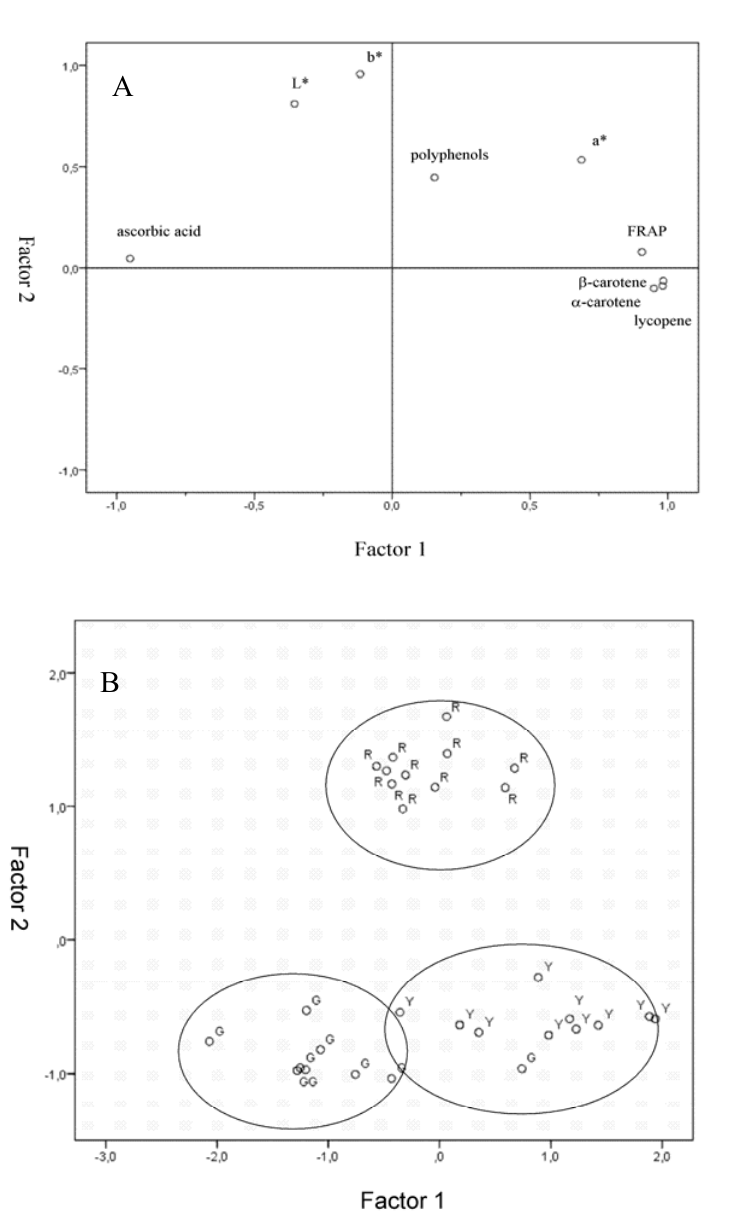
Figure 5. Factor analysis biplots for Gnagnan maturity stage : (A) variables loadings; (B) score